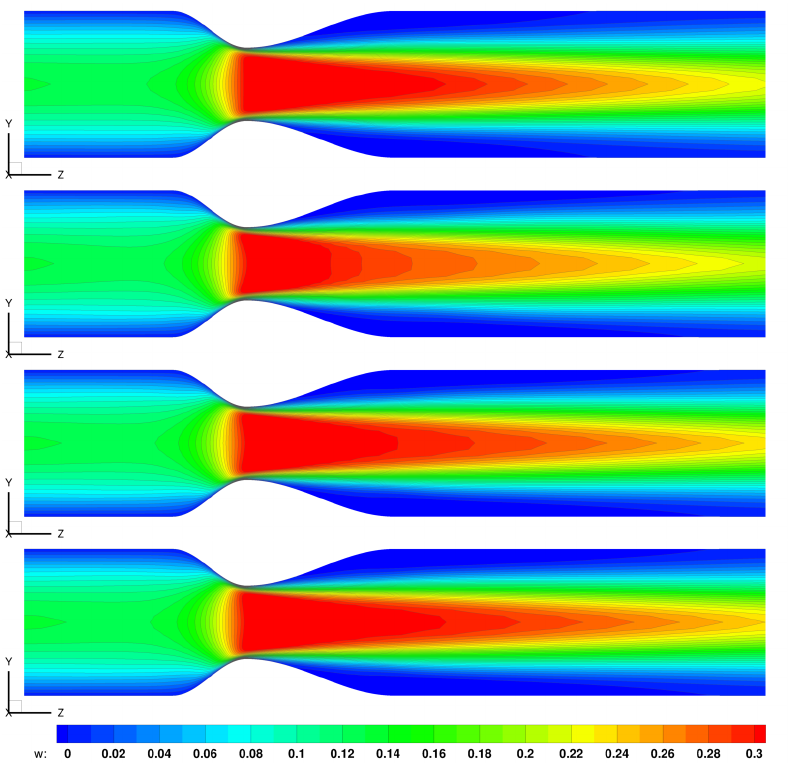
Figure 16. Axial velocity at flow rate Q = 2.0 cm 3 /s—GOB (top figure) and Johnson–Segalman models for a = − 0.9, a = − 0.8, a = − 0.7 (from the top).